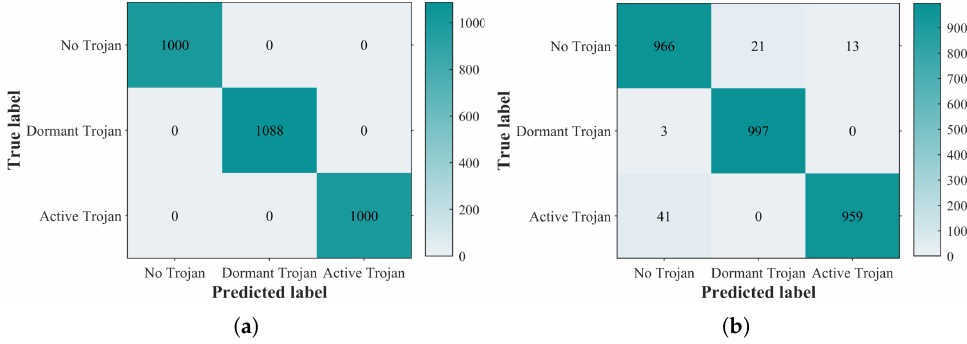
Figure 7. The classification confusion matrices. ( a ) Confusion Matrix of QPSK Signals. ( b ) Confusion Matrix of triangular-wave signals.